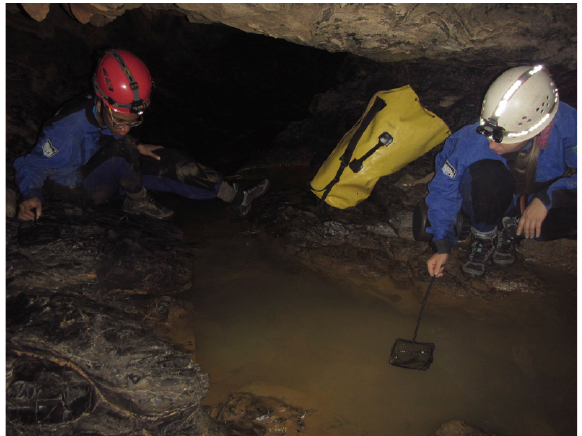
Figure 7. Laboratório de Estudos Subterrâneos team collecting semiaquatic bugs inside Gruta do Tesouro, Piumhi, Minas Gerais state, Brazil. Photo by J.E. Gallão.